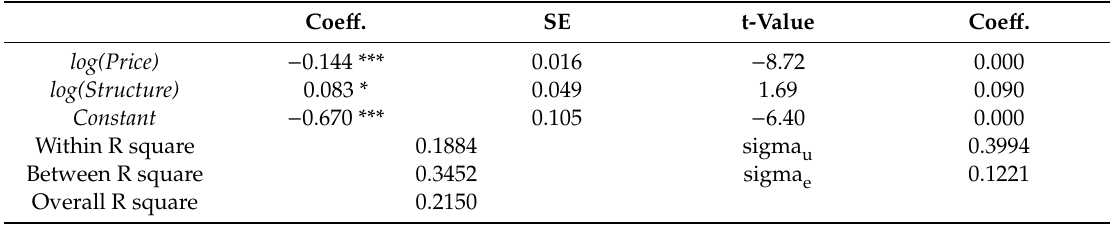
Table 7. Empirical results of electricity prices and